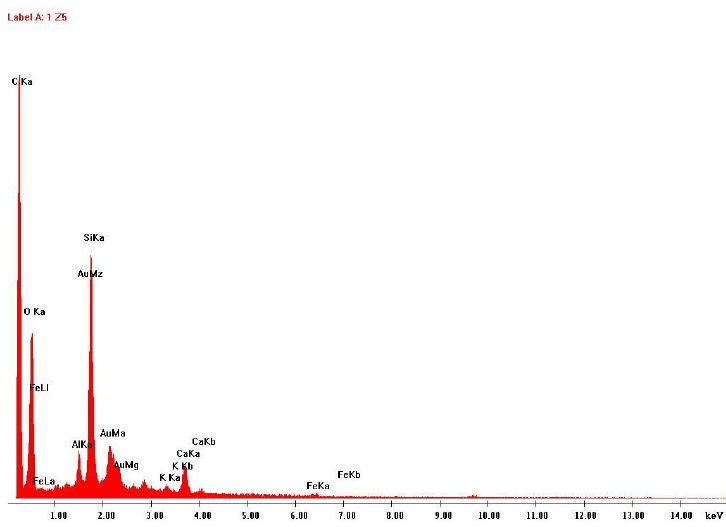
Figure 8. EDS analysis results: Airborne sample collected on quartz filter .